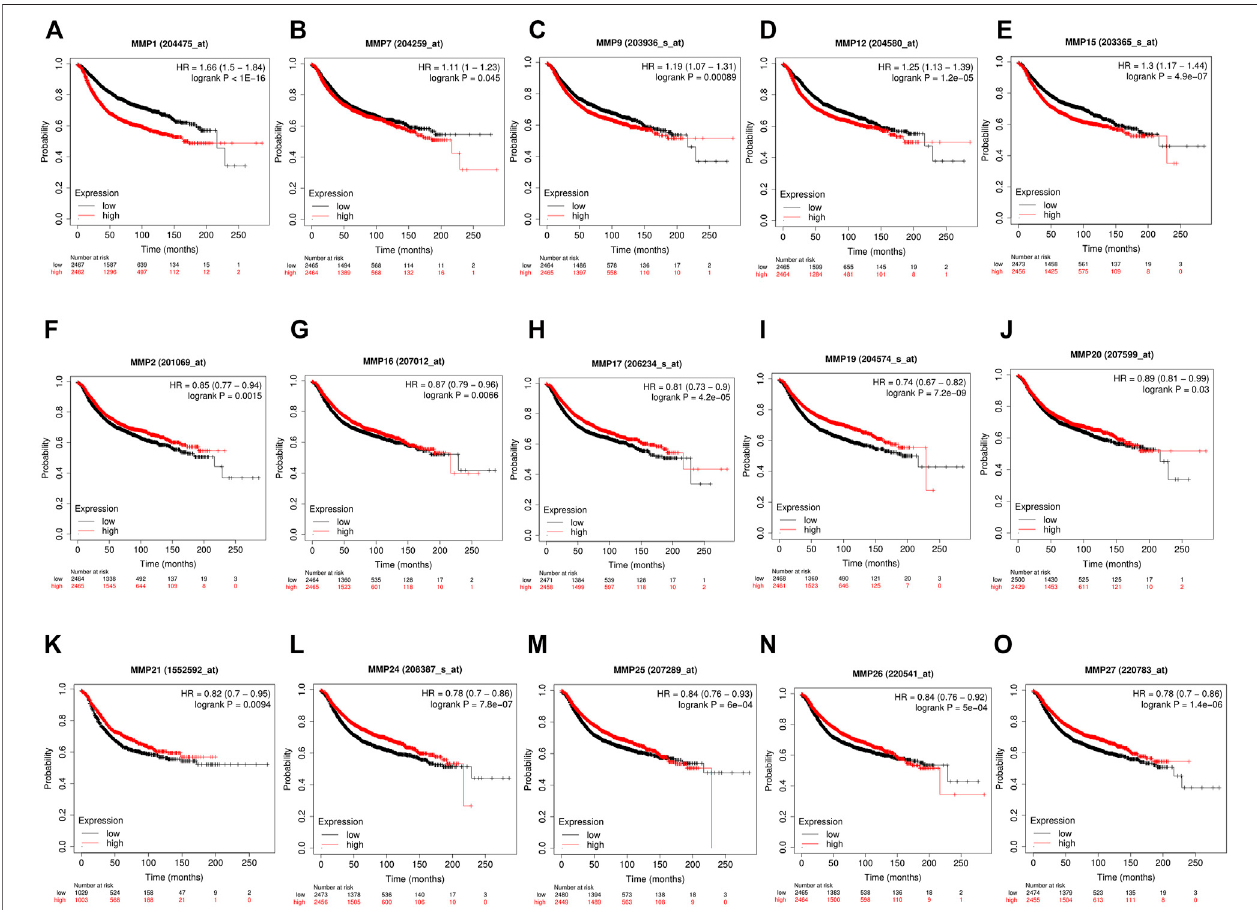
FIGURE 3 | The recurrence-free survival (RFS) of MMPs (Kaplan-Meier Plotter). (A,B,C,D,E) High mRNA expression of MMP1, MMP7, MMP9, MMP12 and MMP15 was correlated with a poorer prognosis, and (F,G,H,I,J,K,L,M,N,O) low expression of MMP2, MMP8, MMP16, MMP17, MMP19, MMP20, MMP21, MMP24, MMP25, MMP26 and MMP27 was correlated with a poorer prognosis in breast cancer patients ( p <